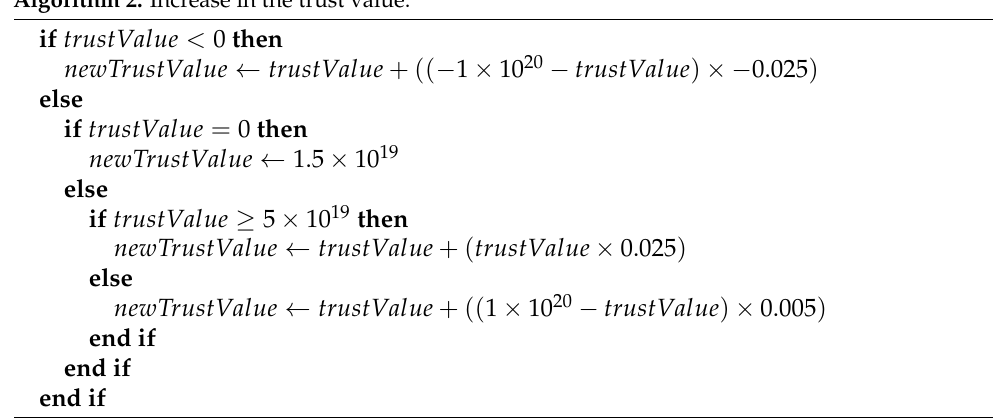
Algorithm 2. Increase in the trust